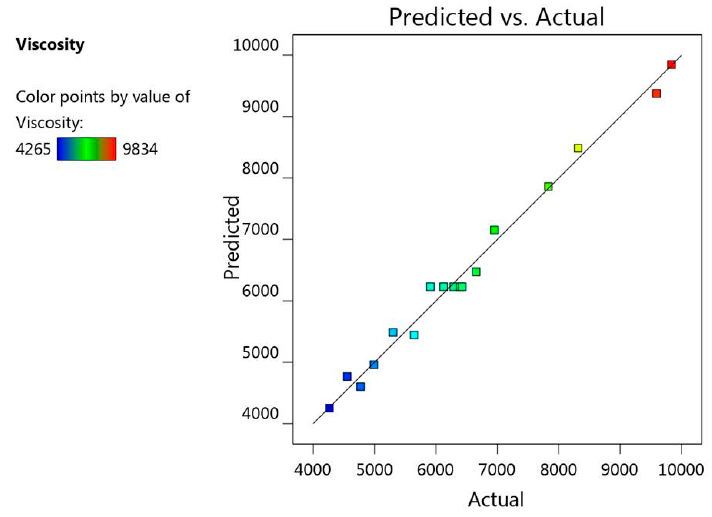
Figure 5. Linear correlation plot between actual and predicted values for viscosity response (R 1 ).